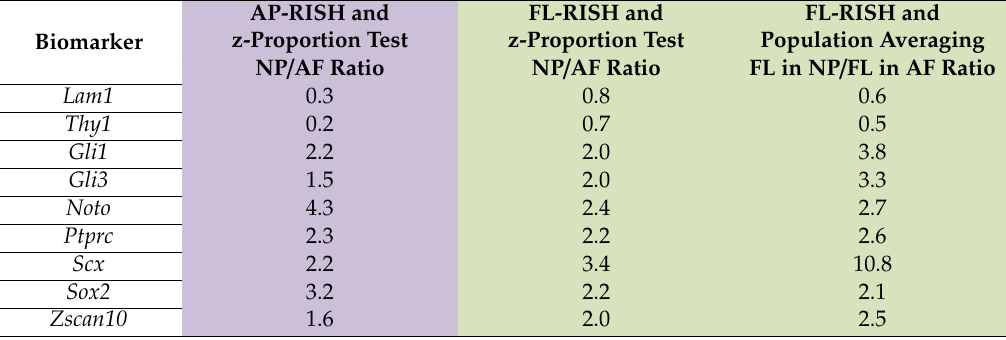
Table 1. Comparison of NP / AF ratio data for nine proposed biomarkers in cells of the outer annulus fibrosus (AF) and nucleus pulposus (NP) of a mature bovine IVD generated through z-proportion test and population averaging comparing data from Li et al [3] using RNA in situ hybridization (AP-RISH) (purple) and this work using Fluorescent RNA in situ hybridization (FL-RISH) (green). Laminin1 ( Lam1 ); Thymocyte di ff erentiation antigen 1 ( Thy1 ); Glioma-associated oncogene 1 ( Gli1 ); Glioma-associated oncogene 3 ( Gli3 ); Notochord ( Noto ); Tyrosine phosphate receptor type C ( Ptprc ); Scleraxis ( Scx ); Sex determining region Y-box 2 ( Sox2 ); Zinc finger and SCAN ( SRE-ZBP, CTfin51, AW-1 and Number 18 cDNA) domain containing transcription factor 10 ( Zscan10